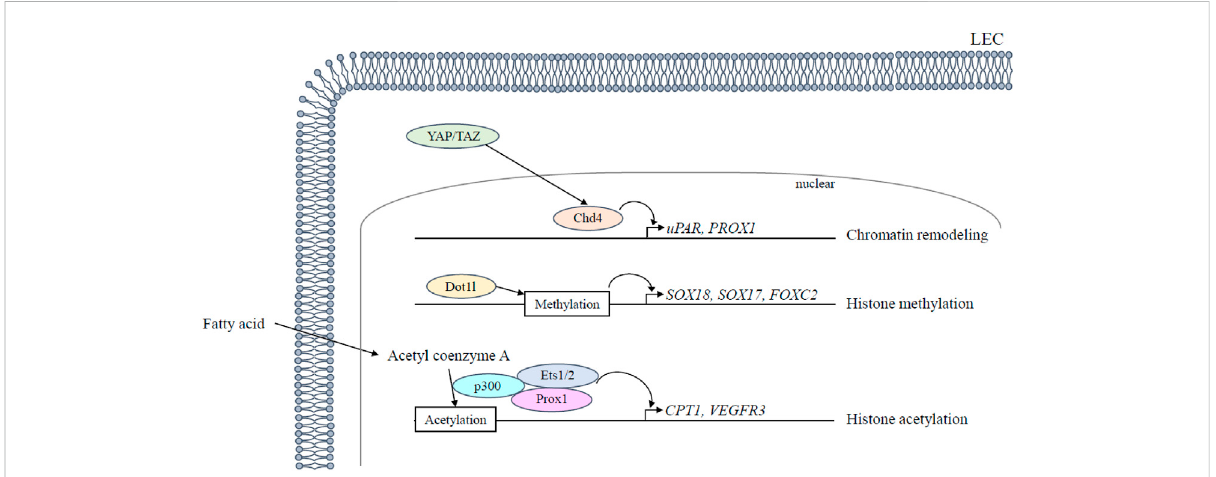
FIGURE 2 Epigenetic regulation in lymphangiogenesis . Epigenetic regulation regarding lymphatic development is mediated in LECs as follows: 1) Chd4 is functionally associated with the Hippo signaling pathway and downregulates Prox1 expression together with Hippo pathway fi nal effectors YAP/ TAZ ; 2) Dot1l promotes transcription by histone methylation of chromatin; 3) Acetyl coenzyme A is used by the histone acetyltransferase p300 that interacts with Prox1 to acetylate histones. ETS 1/2 participates in VEGFR3 gene expression by recruiting the histone acetyltransferase p300 to the VEGFR3 locus and leading to histone acetylation. LEC, lymphatic endothelial